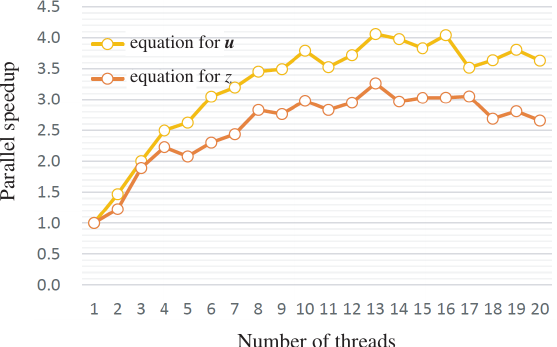
Figure 11. Parallel acceleration for the 51 × 51 × 52 mesh.